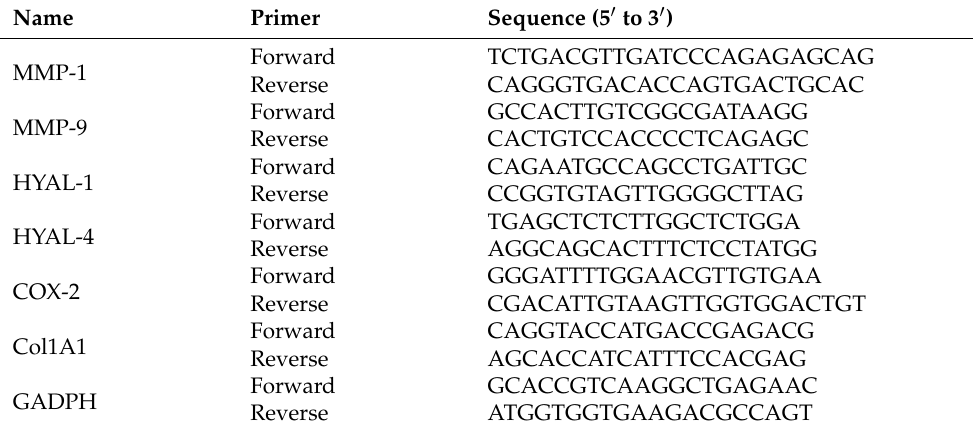
Table 1. Sequences of human primers used in semiquantitative RT-PCR.